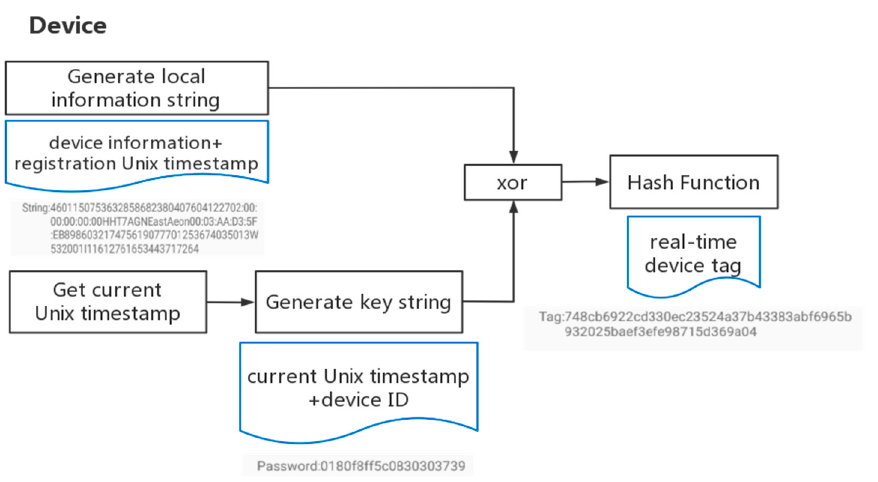
Figure 7. Device registration workflow.